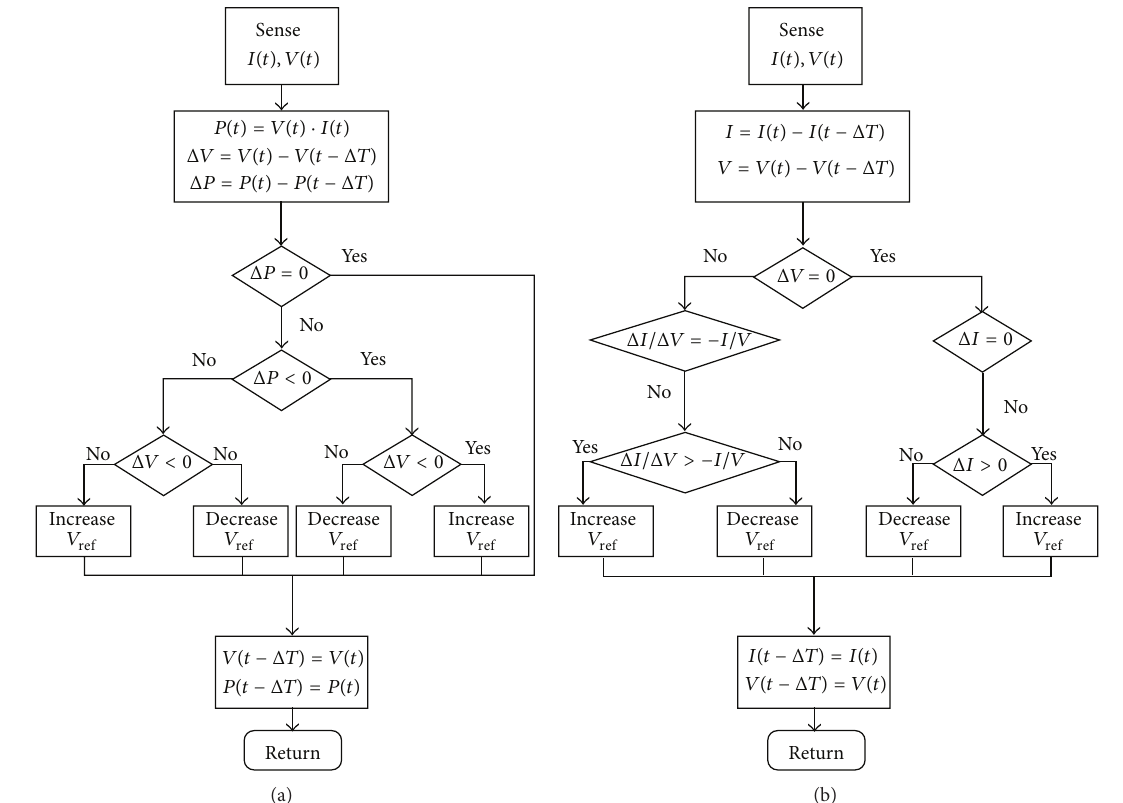
Figure 3: Flowchart representation of MPPT techniques: (a) P&O and (b)